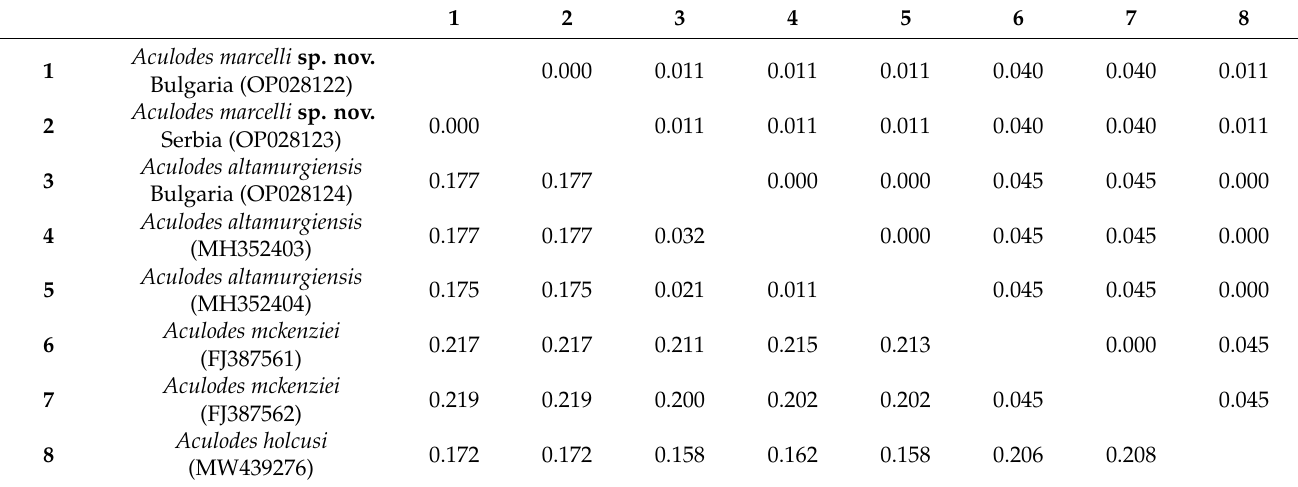
Table 3. Pairwise distance matrix with uncorrected p -distances between Aculodes marcelli sp. nov ., and three congeners ( A. altamurgiensis, A. mckenziei, and A. holcusi ) based on CO1 nucleotide (below the diagonal) and amino acid sequences (above the diagonal). Numbers in column headers refer to species and populations listed in their respective rows. Genbank accession numbers provided in